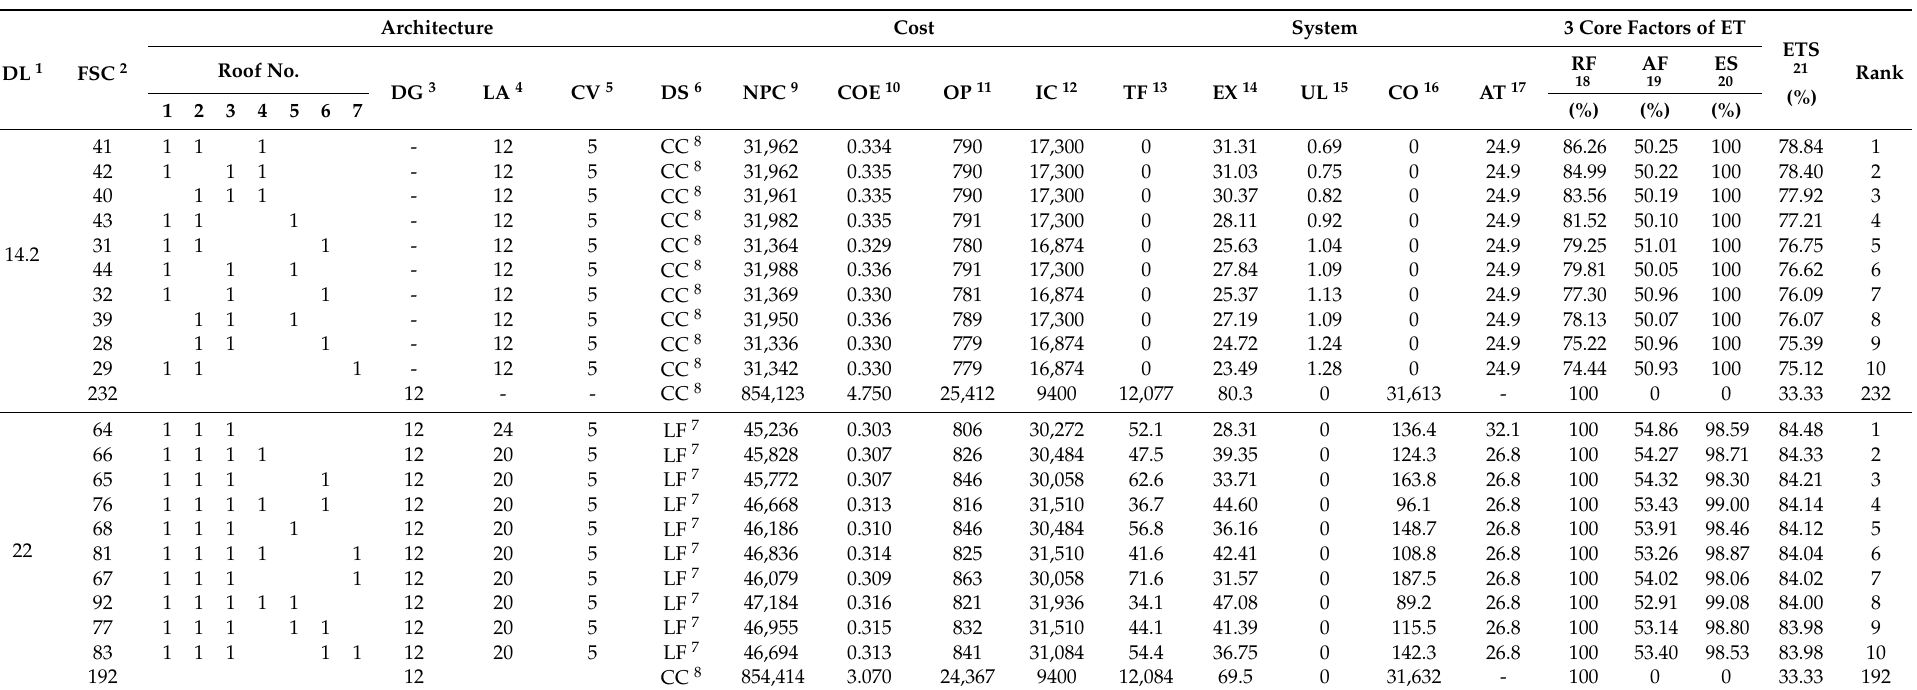
Table 8. Optimization results of the top 10 FSCs and the conventional DG alone based on the ET scoring at 14.2 and 22